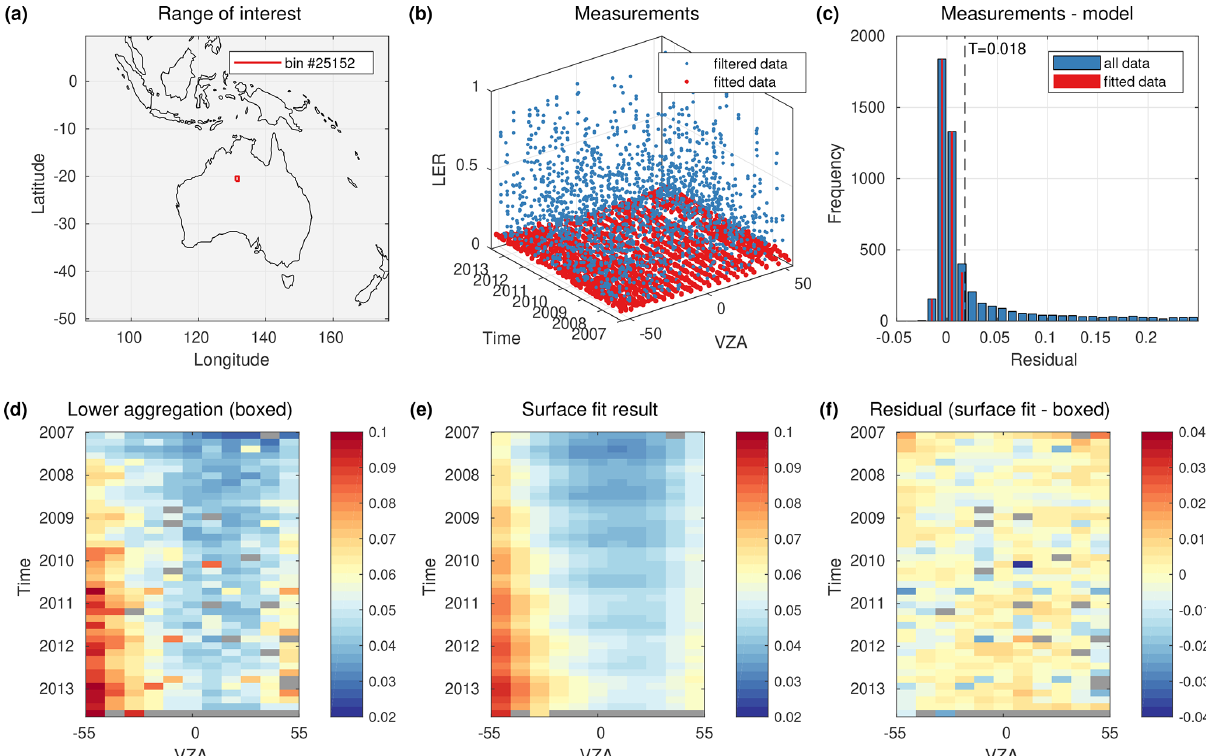
Figure 8. Example surface fit for MSC channel 2 at 382nm and applying binning no. 2 over Australia: (a) the bin of interest ranges from 131 to 132 ◦ E and from 20 to 21 ◦ S, (b) 3-D representation of measurement set (cid:127) 0 (blue) and finally fitted set (cid:127) I (red), (c) frequency distribution of the fit residual, (d) lower accumulation point within each individual 0-D box, (e) surface fit result using model Eq. (4), and (f) difference between panels (d) and (e) . The discretisation chosen for panels (d) – (f) displays a trade-off between accuracy and noise for the sake of clarity. Negative VZA denote the western half of the swath.